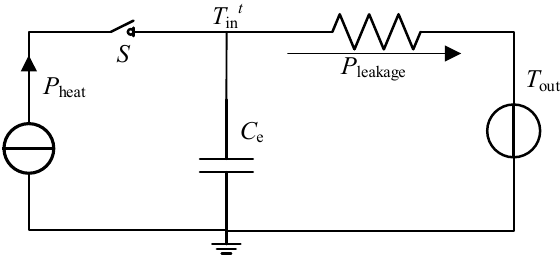
Figure 2. Thermal parameters part of the virtual energy storage (VES) model.